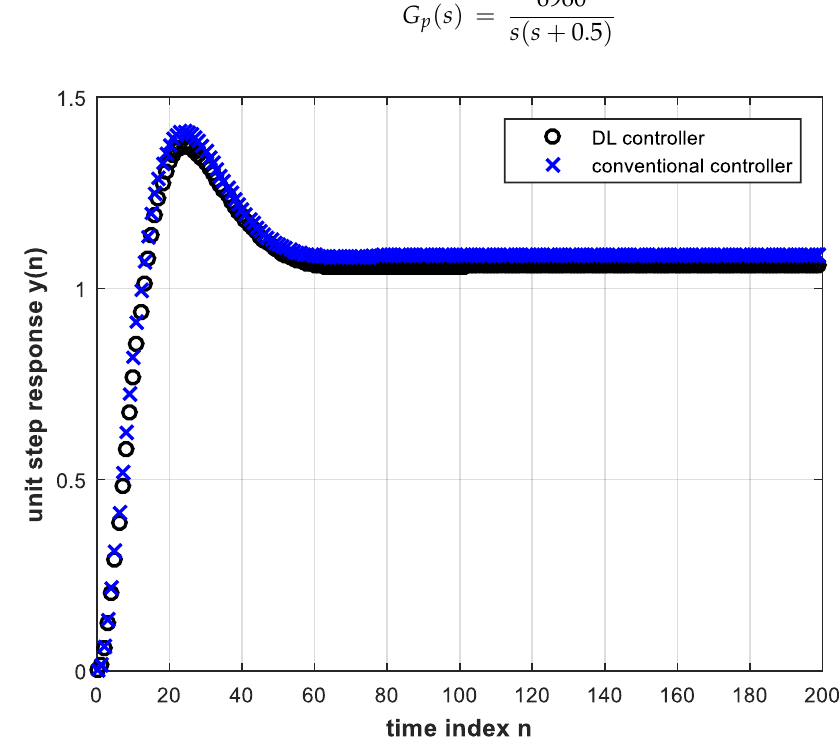
Figure 12. Unit step response of the feedback control system with the trained DL controller (four hidden layers and four input nodes) as well as with the conventional controller, both under pole location change, Equation (17).